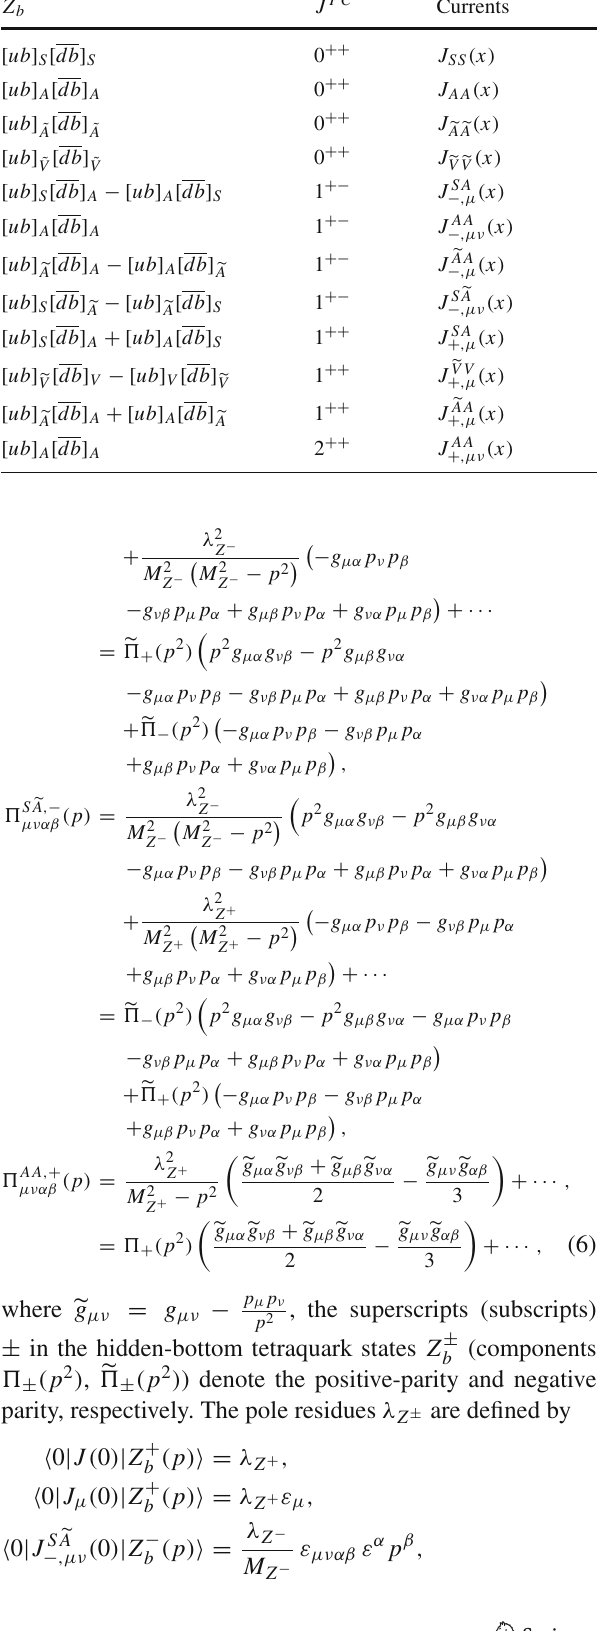
Table 1 The quark structures and corresponding current operators for the hidden-bottom tetraquark states Z b J PC